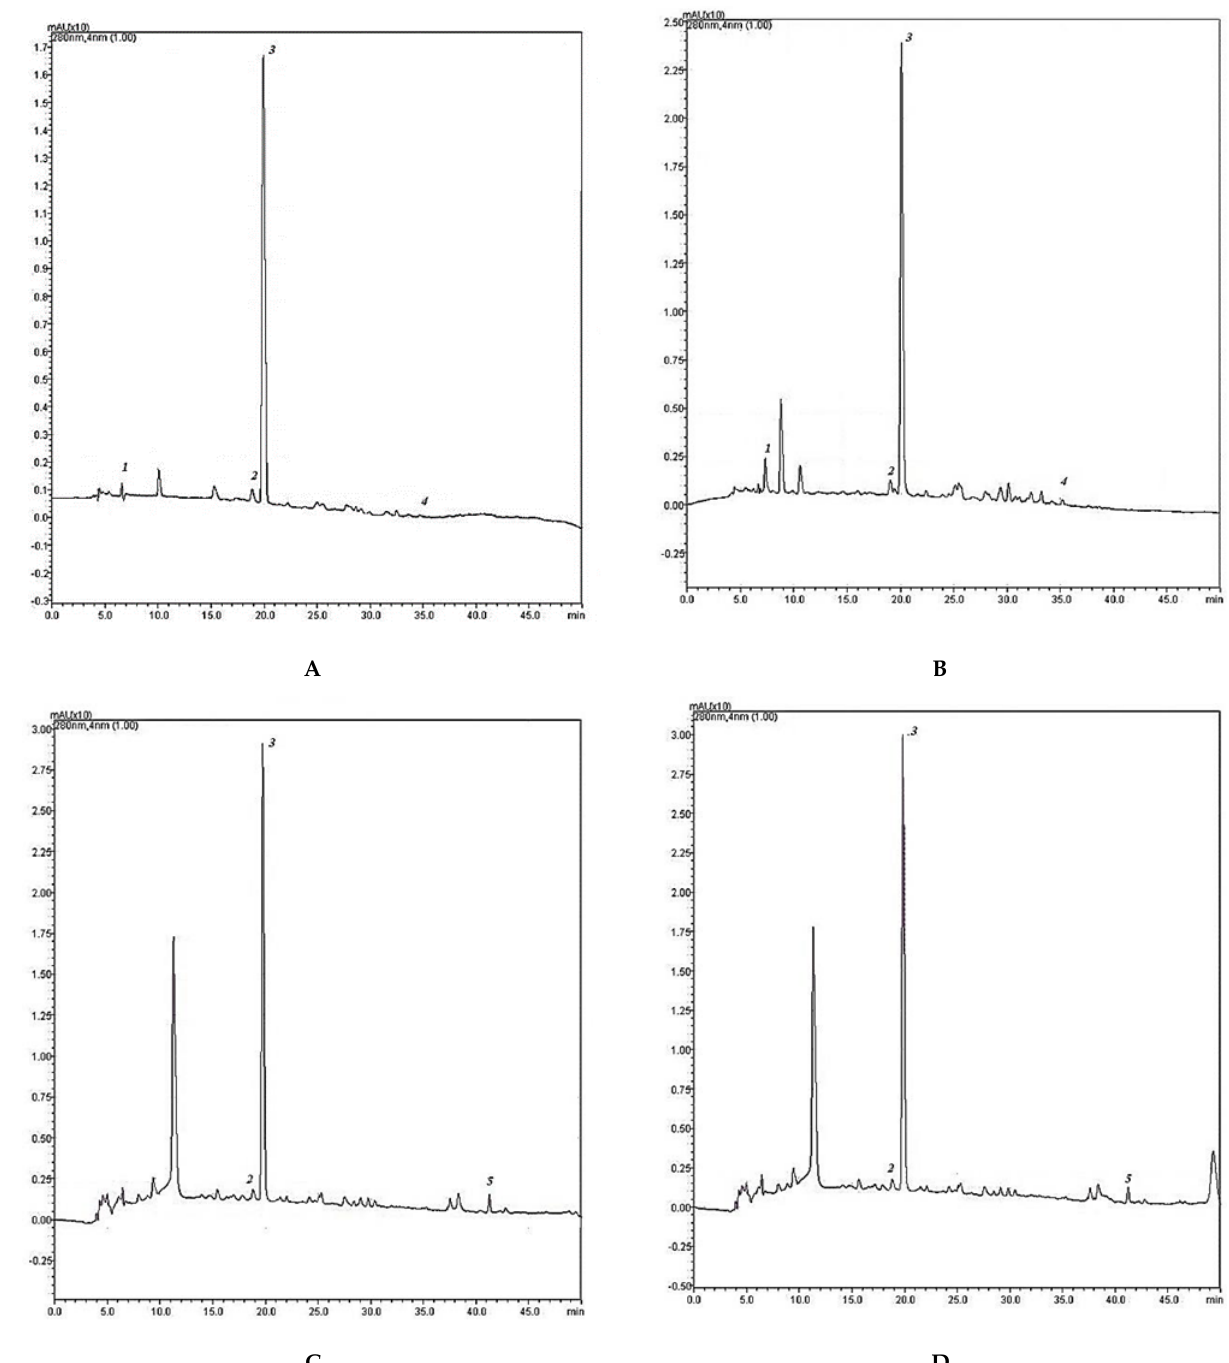
Figure 3. HPLC chromatogram of identified compounds in all the samples at the relative wavelengths to which they have been detected and quantified: 1. EGCG (λ = 280 nm); 2. Chlorogenic acid (λ = 327 nm); 3. Caffeine (λ = 273 nm); 4. Ferulic acid (λ = 325 nm); 5. Quercetin (λ = 365 nm).